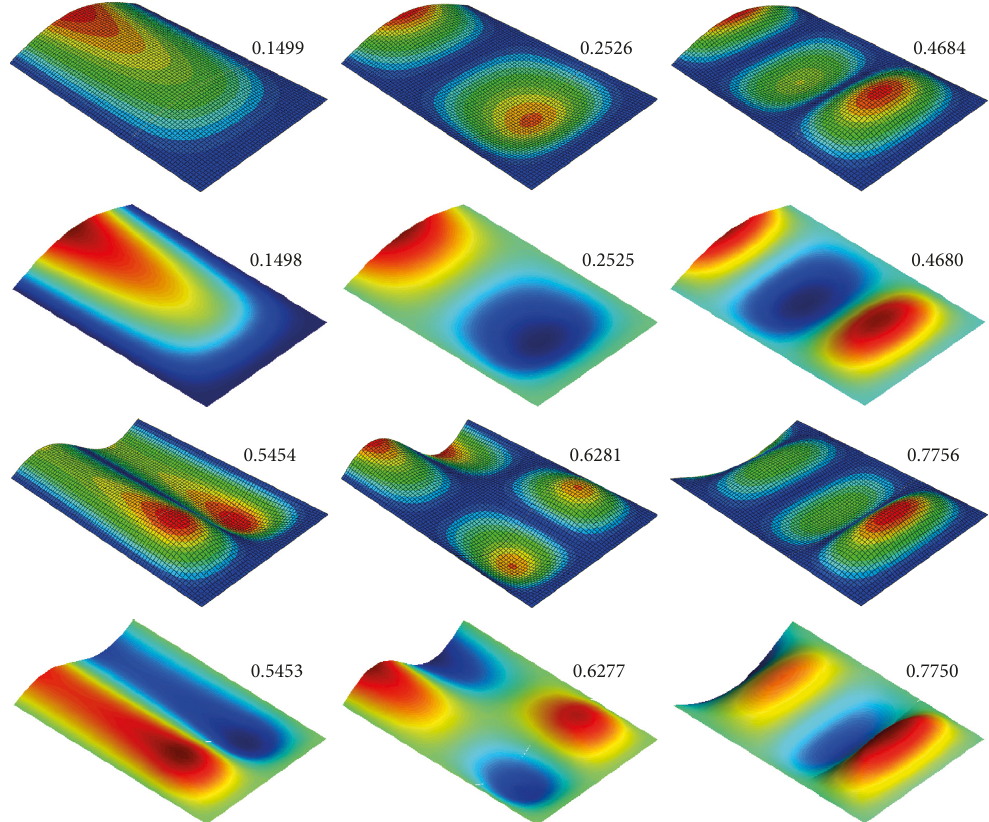
Figure 7: First 6 mode shapes and corresponding natural frequencies of the isotropic stepped plate, plotted using Abaqus (rows 1 and 3) and FREEVIB (rows 2 and 4).